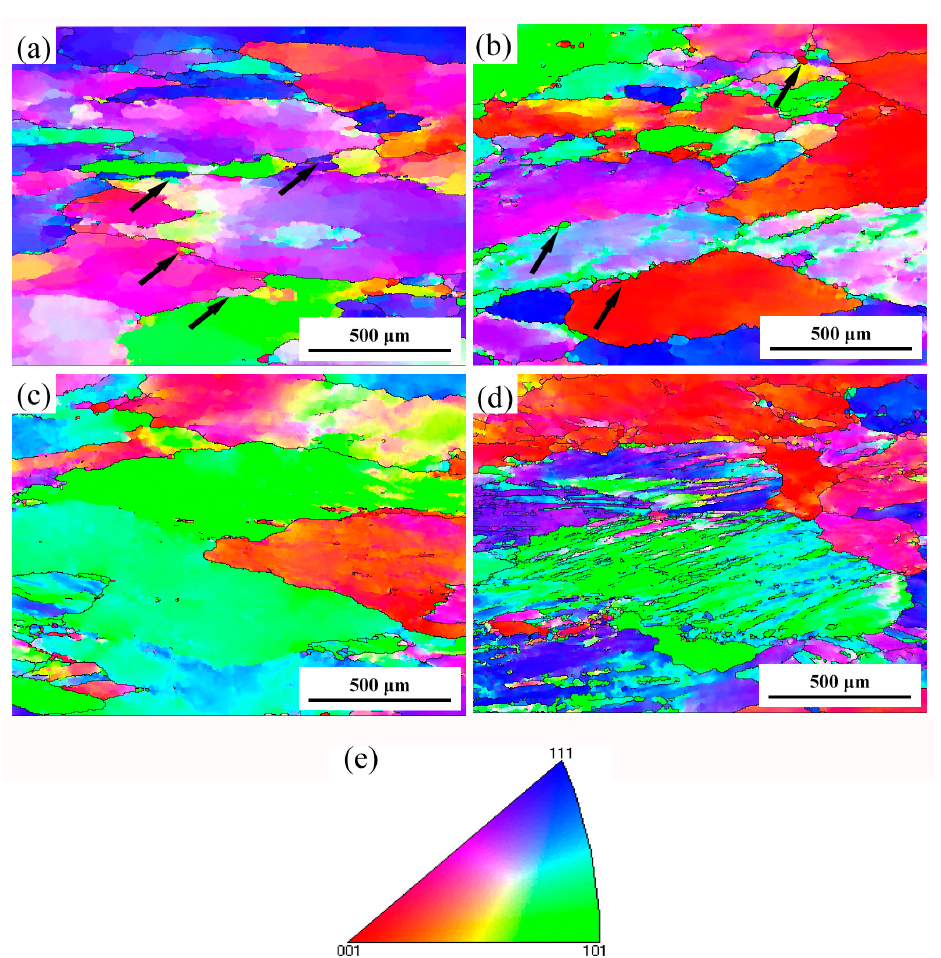
Figure 6. Microstructures of the specimens deformed under different parameters. ( a ) 500 °C /0.01 s − 1 ; ( b ) 450 °C /0.1 s − 1 ; ( c ) 450 °C /1 s − 1 ; ( d ) 450 °C /10 s − 1 , and ( e ) representation of the color code used to identify the crystallographic orientations on standard stereographic projection (red: [0 0 1]; blue: [1 1 1]; green: [1 0 1]).